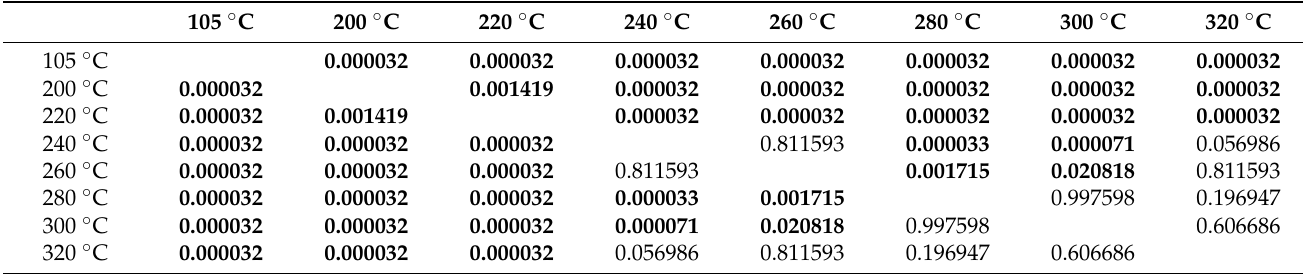
Table A1. Significant differences for the EMC variable for the effect of torrefaction temperature (TT) according to Tukey’s test (HSD) for lemon peels.